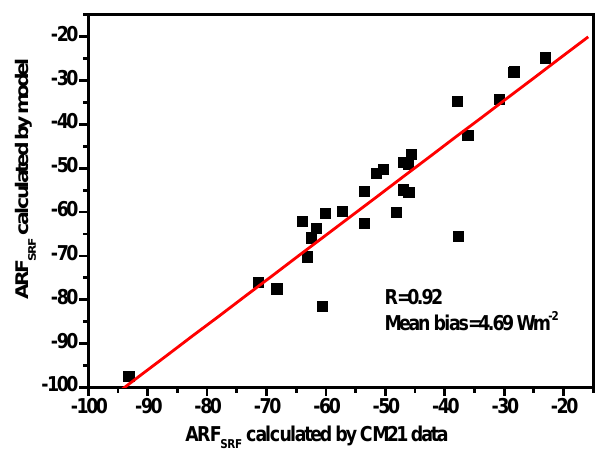
Fig. 7. Scattergrams of daily mean ARF calculated by CM21 observation and the radiative transfer model.